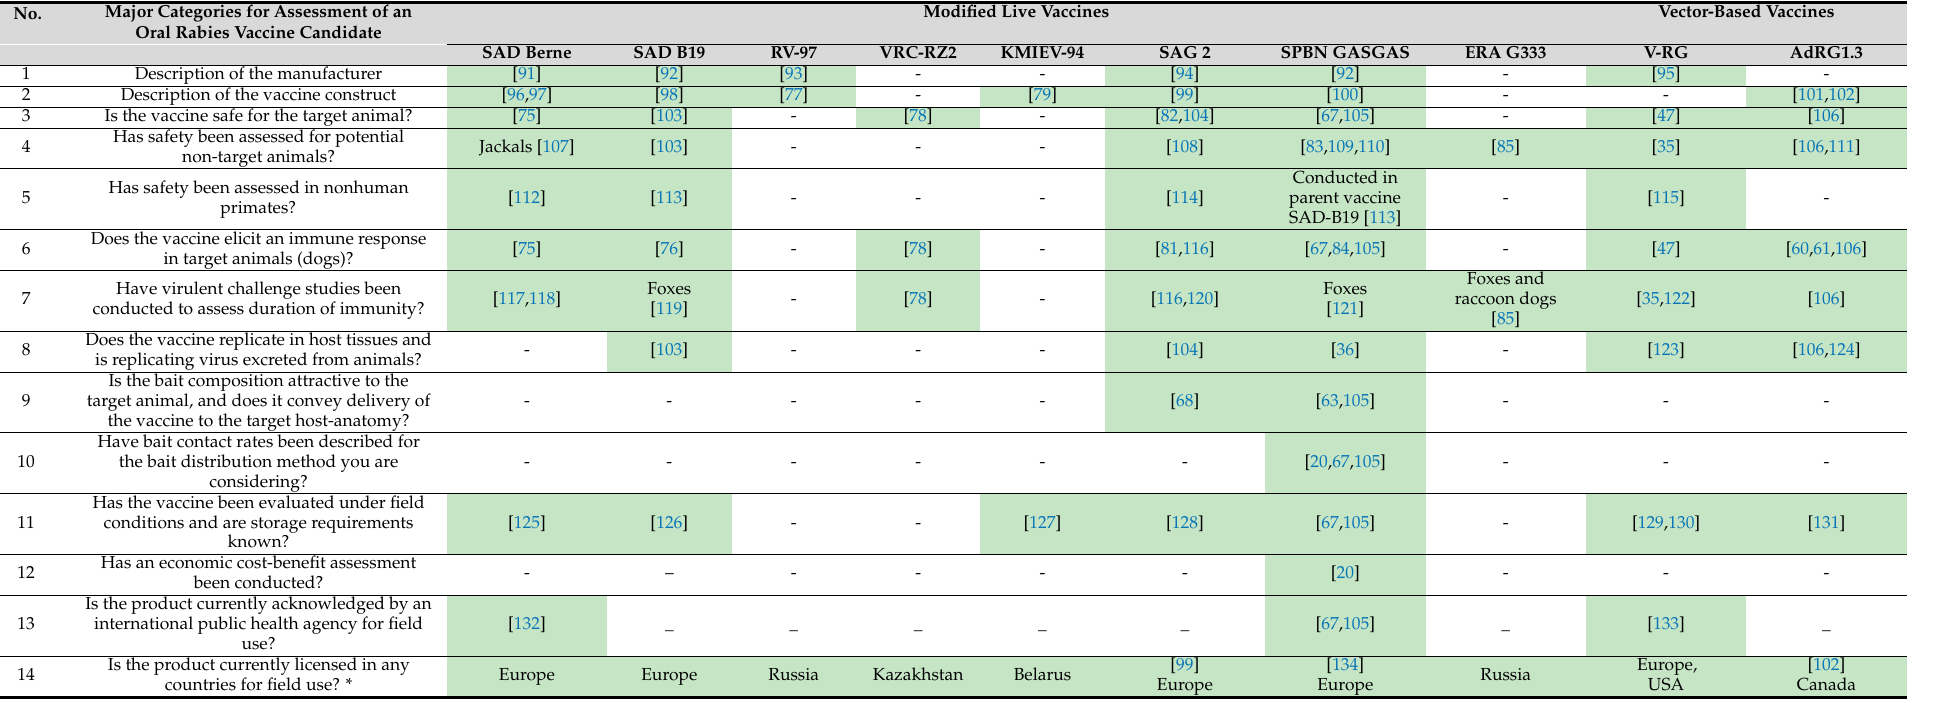
Table 2. Recommendations outlined by WHO and World Organisation for Animal Health expert committee on the suitability for field trials in dogs, and reference supporting fulfilment of that recommendation for each of the oral rabies vaccines currently used in wildlife. In addition to these criteria are five further considerations which are not listed as they are not specific to a vaccine. These are as follows: “Is the community supportive of oral rabies vaccination of dogs?”, “Can the